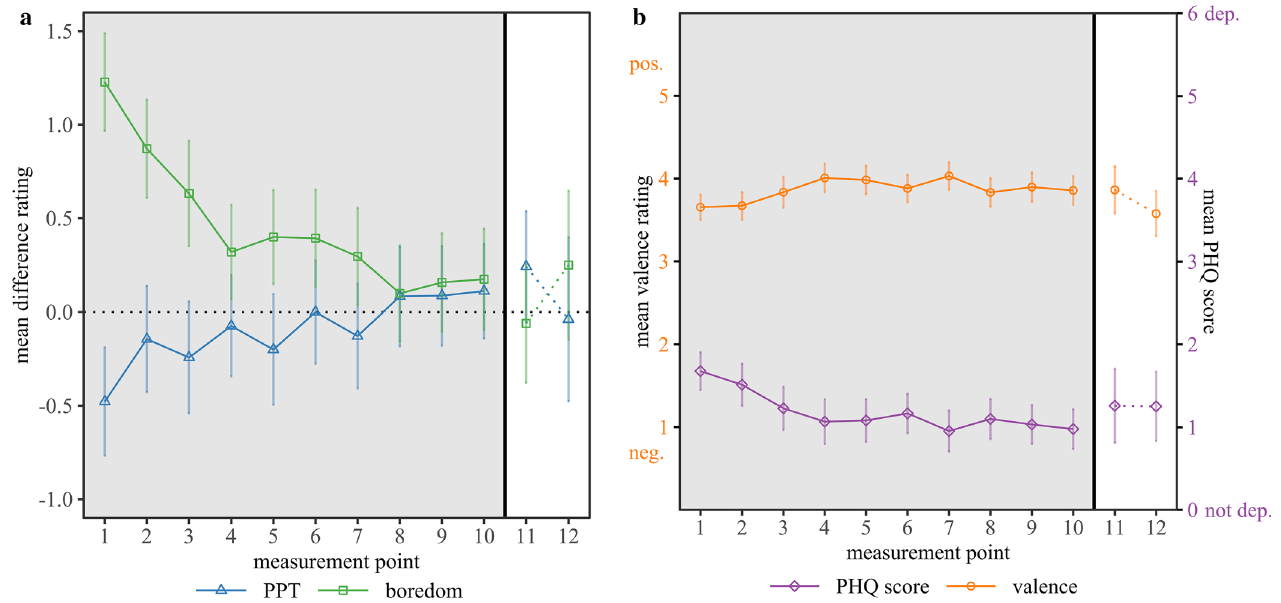
Figure 2. ( a ) Mean differences between the pandemic and pre-pandemic ratings are depicted for the perceived passage of time (PPT) (blue triangle) and boredom (green square), as a function of measurement point. The dotted horizontal line marks the level of no difference between pandemic and pre-pandemic ratings. Positive values indicate faster pandemic PPT/higher pandemic boredom compared to the pre-pandemic ratings. ( b ) Mean valence ratings (left y-axis) and mean PHQ scores (right y-axis) during the pandemic are displayed as a function of measurement point. Note that higher PHQ scores (purple diamond) indicate more depressive symptoms. Higher valence ratings (orange circles) indicate a positive emotional state, while lower values represent a negative emotional state. A value of 3 indicates a “neutral” state. The main study included measurement points